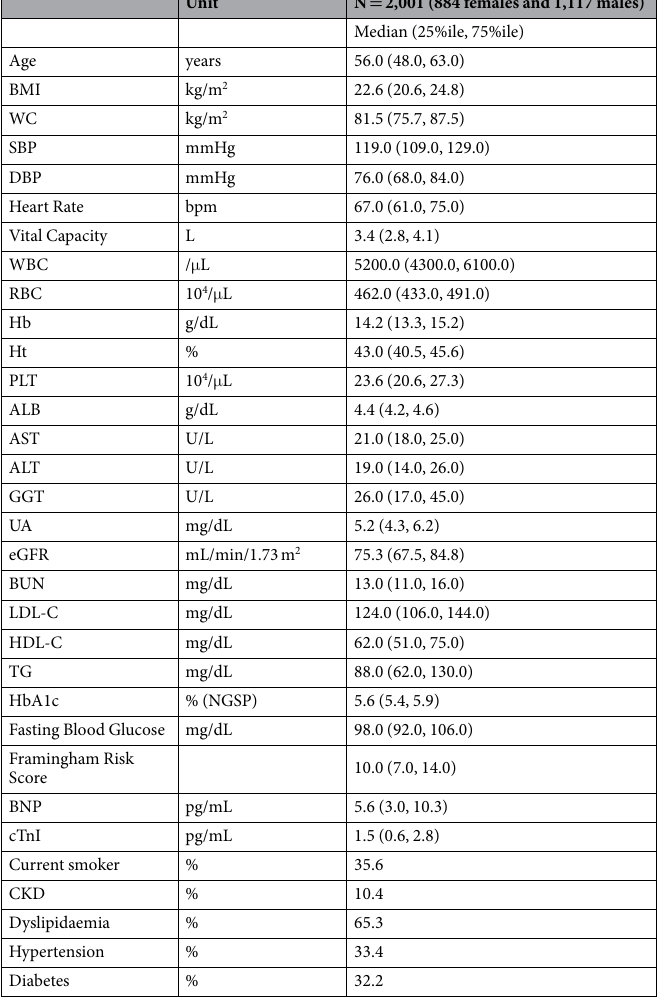
Table 1. Basic Characteristics of the Total Cohort. BMI, body mass index; WC, waist circumference; SBP, systolic blood pressure; DBP, diastolic blood pressure; WBC, white blood cell count; RBC, red blood cell count; Hb, haemoglobin; Ht, haematocrit; PLT, platelet count; ALB, albumin; AST, aspartate aminotransferase; ALT, alanine aminotransferase; GGT, gamma glutamyl transferase; UA, uric acid; eGFR, estimated glomerular filtration rate; BUN, blood urea nitrogen; LDL-C, low-density lipoprotein cholesterol; HDL-C, high-density lipoprotein cholesterol; TG, triglycerides; HbA1c, haemoglobin A1c; BNP, B-type natriuretic peptide; cTnI, cardiac troponin I; CKD, chronic kidney